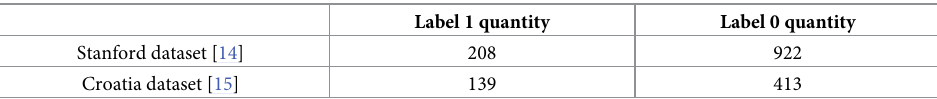
Table 2. Label distribution in MRI